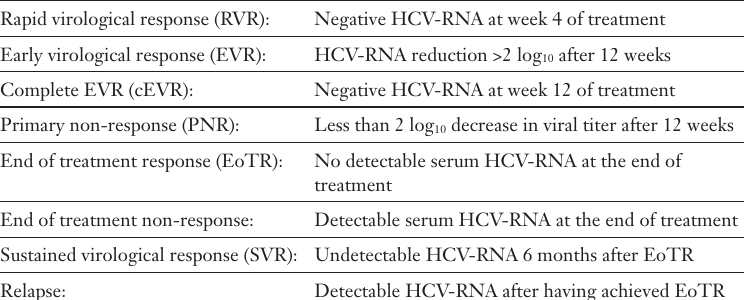
Definitions of treatment response. Rapid virological response (RVR): Negative HCV-RNA at week 4 of treatment Early virological response (EVR): HCV-RNA reduction >2 log 10 after 12 weeks Negative HCV-RNA at week 12 of